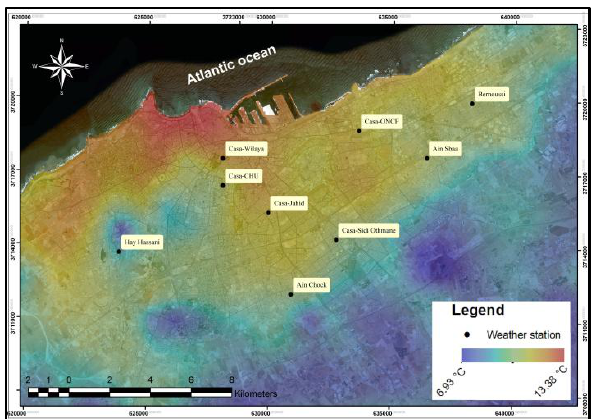
Figure 11. Spatial distribution of minimum air temperature estimated from nighttime MODIS observation during the 18th of December